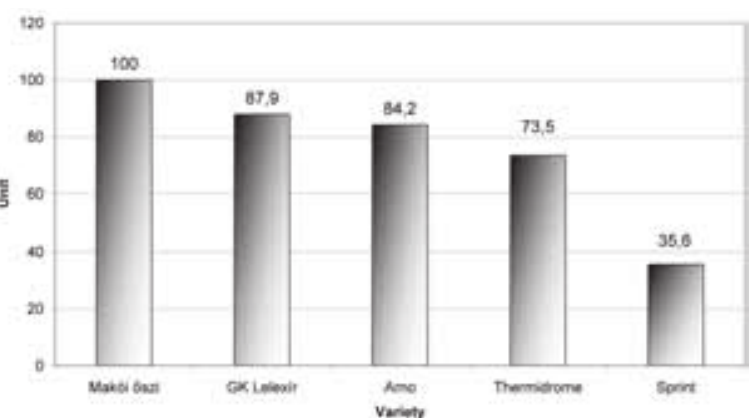
Figure 1 Dially-sulfone content int he examined garlic varieties